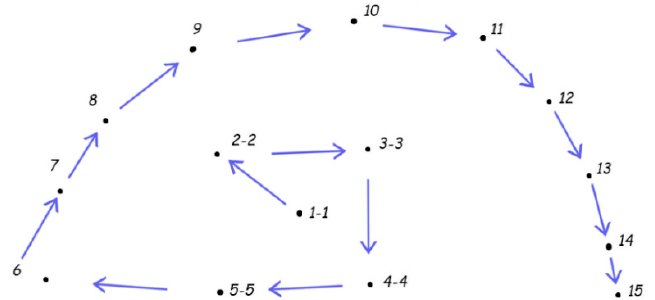
Figure 2. Arrangement and time sequence of the exemplary multiple blast; horizontal cross-section of the location. Sequence of the elemental shots is shown with the arrows. At first, the five pairs of charges were ignited; these were situated at the center.